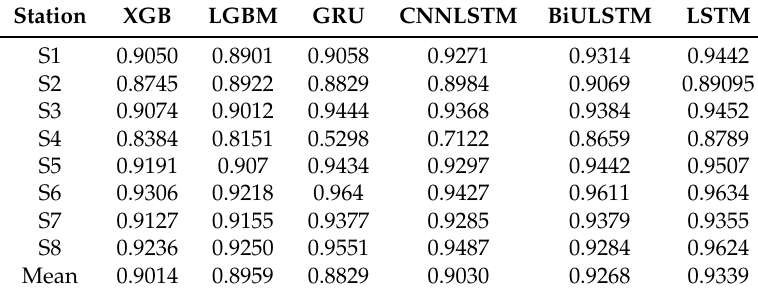
Table A4. Models results for IOA